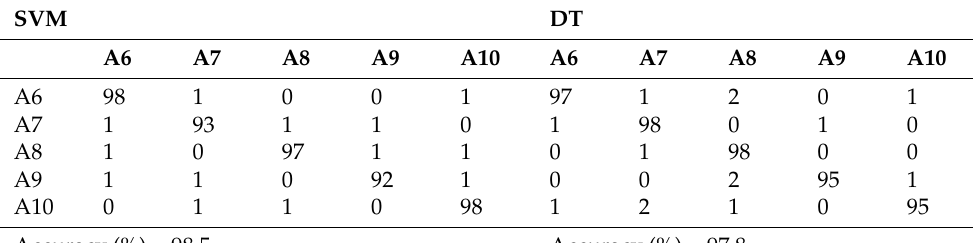
Table 8. Classification of A6–A10 signal events.